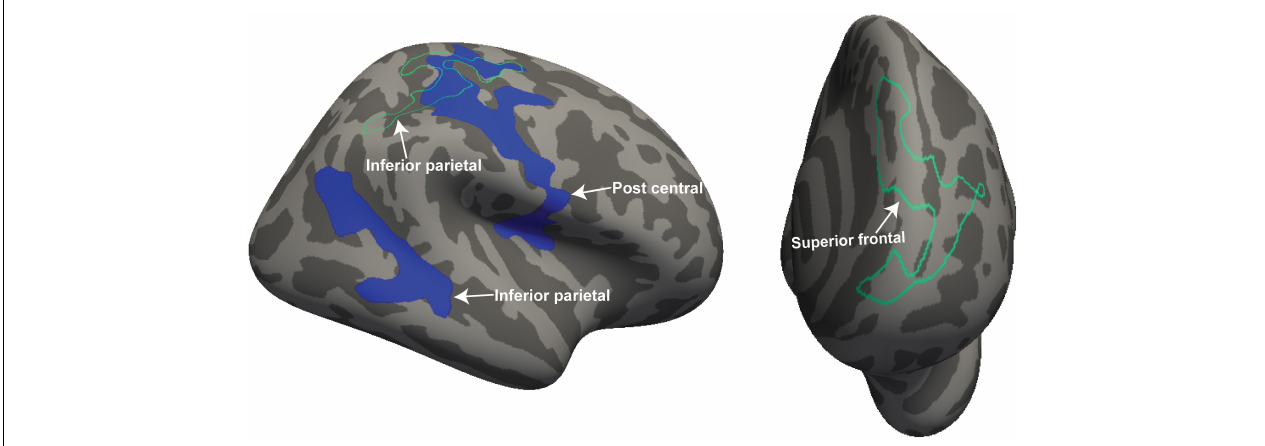
FIGURE 2 | For ME/CFS and HC, significant clusters from interaction-with-group regressions for 2 clinical regressors (“Fatigue” and “HRV”). The volume and thickness cluster of the post central gyrus and inferior parietal was observed in the left hemisphere when regressed with “Fatigue” (left side). The thickness cluster of the superior frontal gyrus was detected at the left hemisphere when regressed with “HRV” (right side). The volume is represented with filled blue color whereas thickness is represented by unfilled green color. Significant volume and thickness clusters were overlaid on the inflated brain (left and right hemisphere) available in the FreeSurfer.